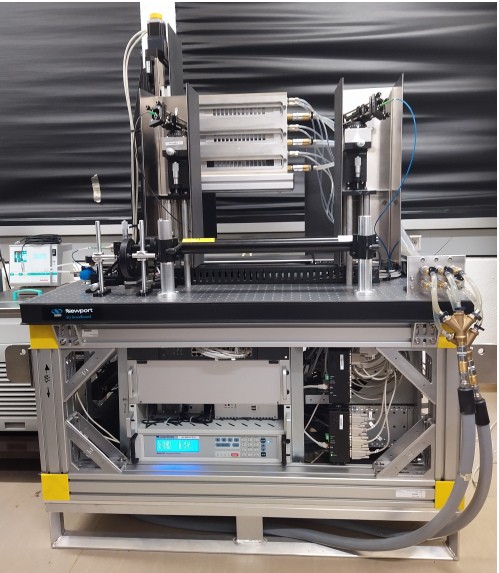
Figure 7. Photograph of the complete SANS/DLS setup with carrier